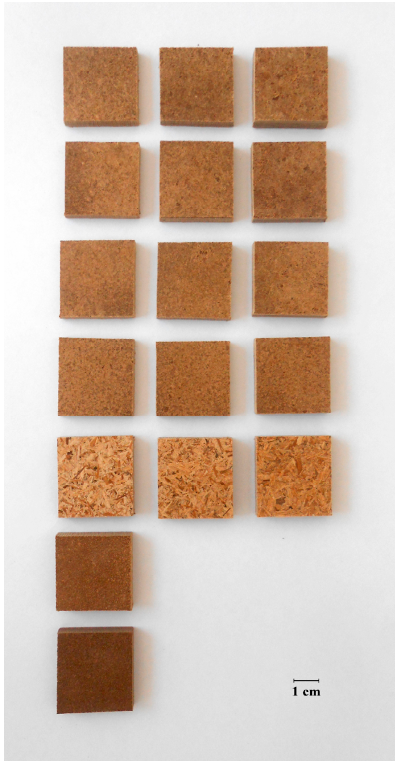
Figure 2. Test specimens of the binderless fiberboards produced during this study. Row 1–4, Fiberboards produced from extrusion refined straw with a L/S ratio of 1.0, 0.8, 0.6 and 0.4, respectively; Row 5, Fiberboards produced from milled straw; Columns 1–3, Fiberboards produced with a press cake content of 10%, 25% and 40%, respectively; Row 6, Fiberboard produced from premixed extrusion refined straw at L/S ratio 0.4 and 40% of press cake; Row 7, Fiberboard produced from premixed extrusion refined straw at L/S ratio 0.4 and 40% of press cake and subsequently heat treated at 200 °C.